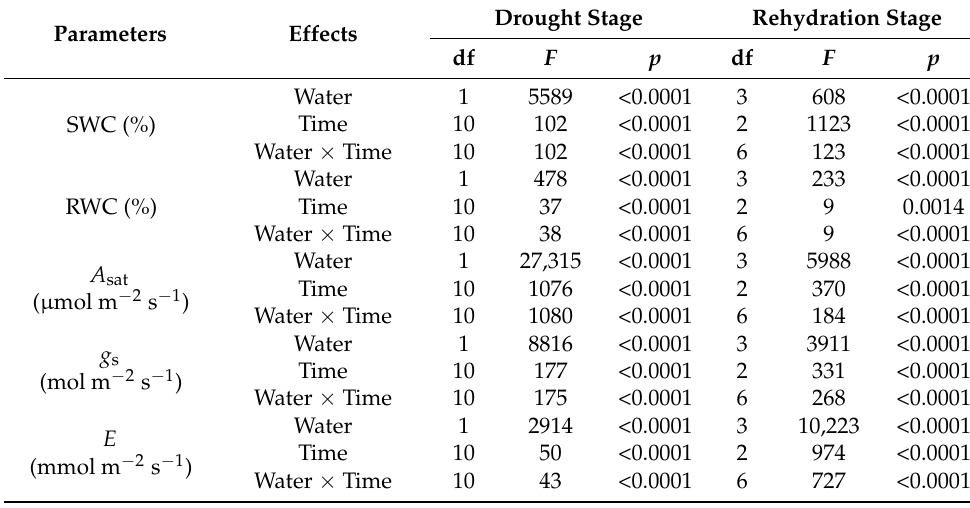
Figure 1. Dynamics of water content in Pinus massoniana Lamb. seedlings after drought and subsequent rehydration. Panels ( A , C ) represent the dynamics of SWC and RWC un- der drought treatment, and panels ( B , D ) represent the dynamics of SWC and RWC after subsequent rehydration. Different lowercase letters indicate significant differences between sampling dates within the same treatment ( p < 0.05), while different capital letters indicate significant differences between treatments on the same sampling date ( p < 0.05). Dashed lines represent the time when PLC reached 50% (PLC50, green), 85% (PLC85, brown), or 100% (PLC100, orange), while rehydration (PLC50 − R, PLC85 − R, and PLC100 − R, respec- tively) followed the achievement of these levels immediately. Values represent means ± SD ( n = 3). Table 1. Results of two-way ANOVA during the drought and rehydration stages. The degree of freedom, F -value, and p -value are